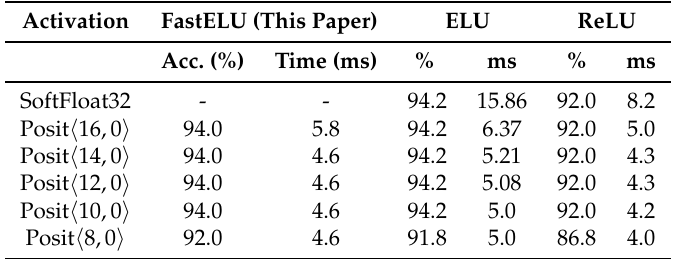
Table 9. Comparison using Posits for the GTRSB dataset (see Table